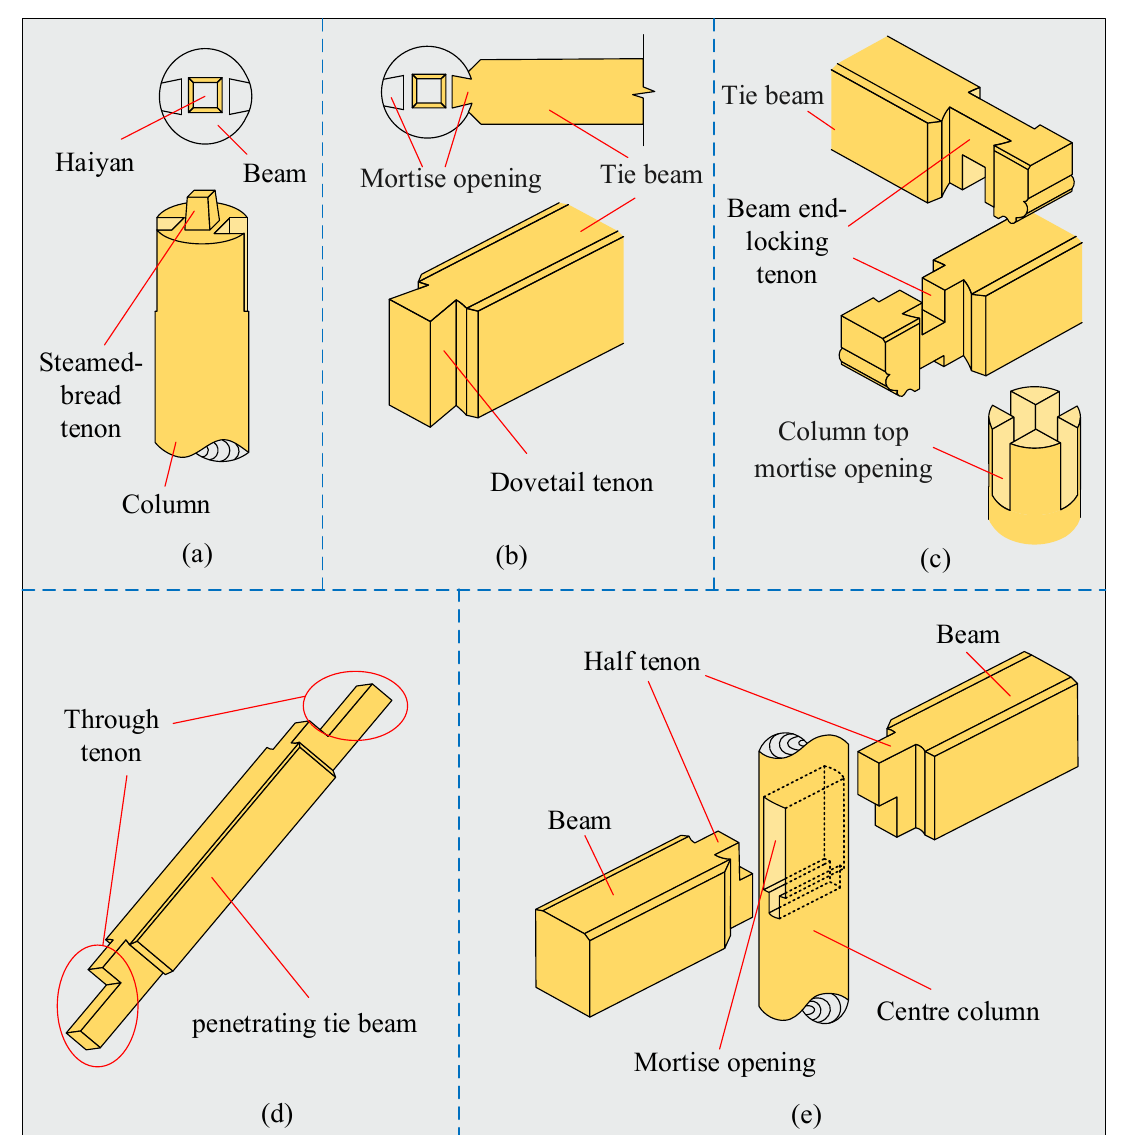
Figure 5. Tenon–mortise joints for joining horizontal and vertical structural components. ( a ) Steamed-bread tenon; ( b ) Dovetail tenon; ( c ) Beam end-locking tenon; ( d ) Through tenon; ( e ) Half tenon.